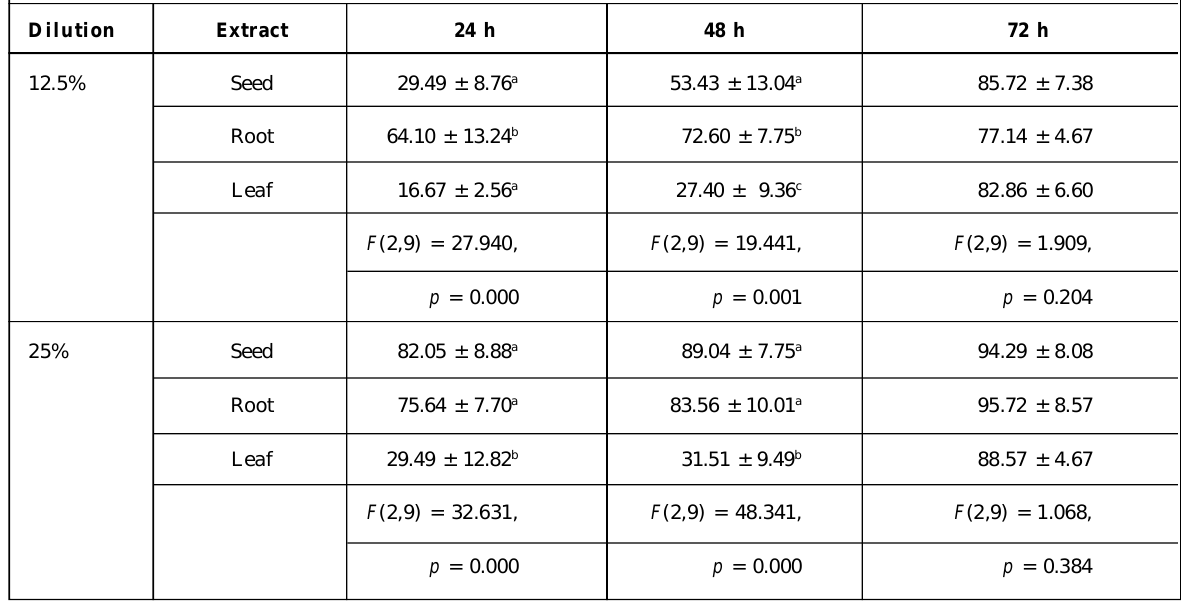
Table 1: Nematicidal activity on Globodera rostochiensis 2 nd stage juveniles of extracts of Datura stramonium